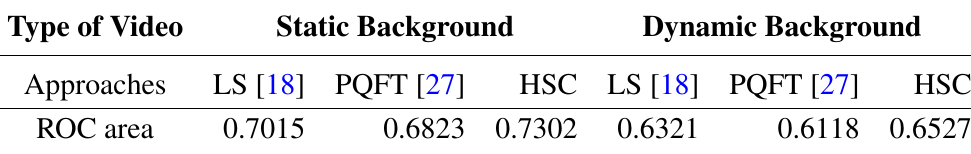
Table 2. receiver operating characteristic (ROC) areas of different